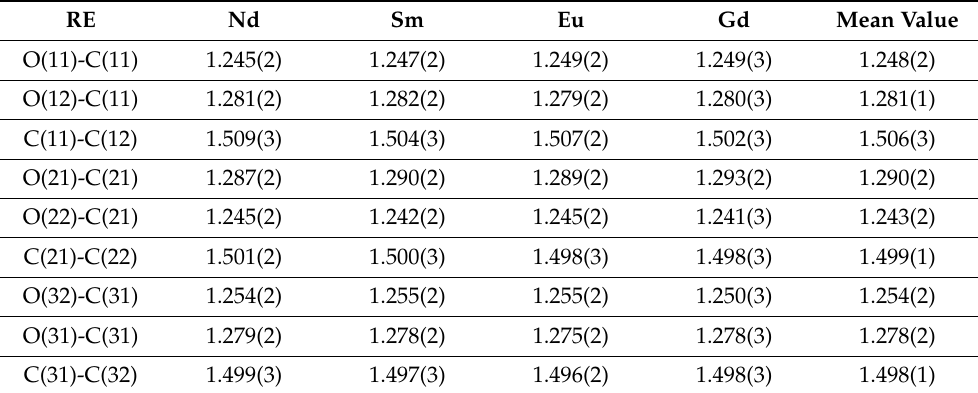
Table 3. Individual bond lengths [Å] within the different acetate groups of the RE(OAc) 3 · 2AcOH structure type groups, standard deviations in brackets.